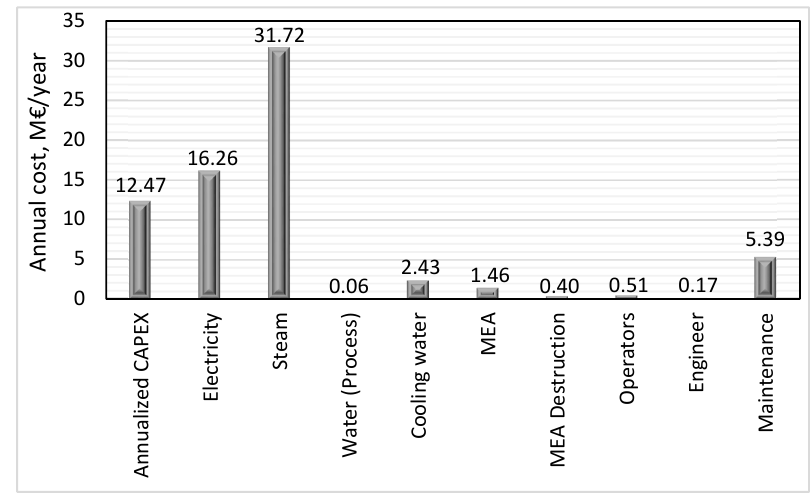
Figure 4. Annual cost distribution.